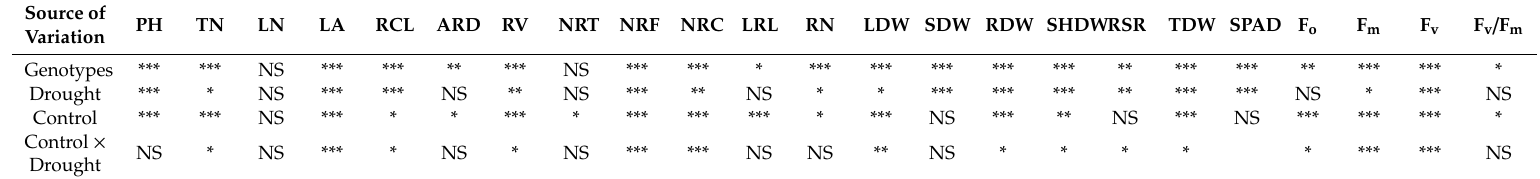
Table 1. Analysis of variance across the genotype, treatments, and their interaction for the morphological parameters measured viz plant height (PH, cm plant − 1 ), tiller number (TN, no. plant − 1 ), leaf number (LN, no. plant − 1 ), leaf area (LA, cm 2 plant − 1 ), leaf dry weight (LDW, g plant − 1 ), stem dry weight (SDW, g plant − 1 ), root dry weight (RDW, g plant − 1 ) shoot dry weight (SHDW, g plant − 1 ), root / shoot ratio (RSR), total dry weights (TDW, g plant − 1 ), cumulative root length (RCL, cm plant − 1 ), average root diameter (ARD, mm plant − 1 ), root volume (RV, cm 3 plant − 1 ), number of root tips (NRT, no. plant − 1 ), number of root forks (NRF, no. plant − 1 ), number